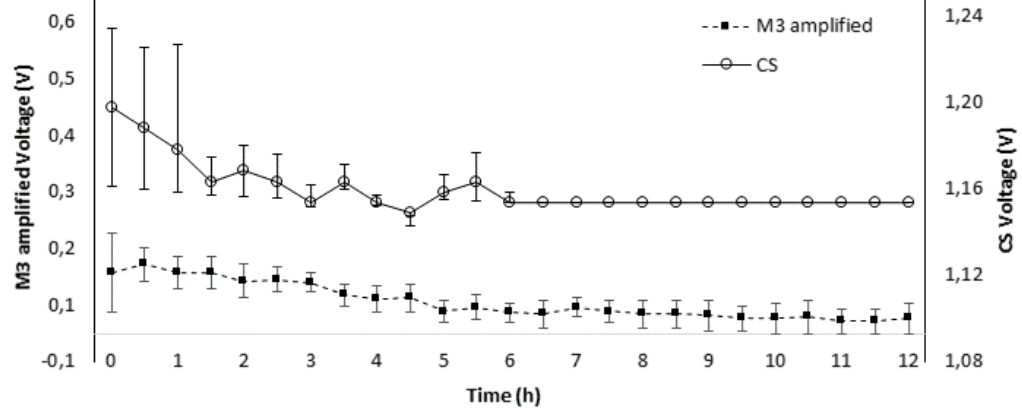
Figure 5. The MP oxygen sensors’ lifetime.